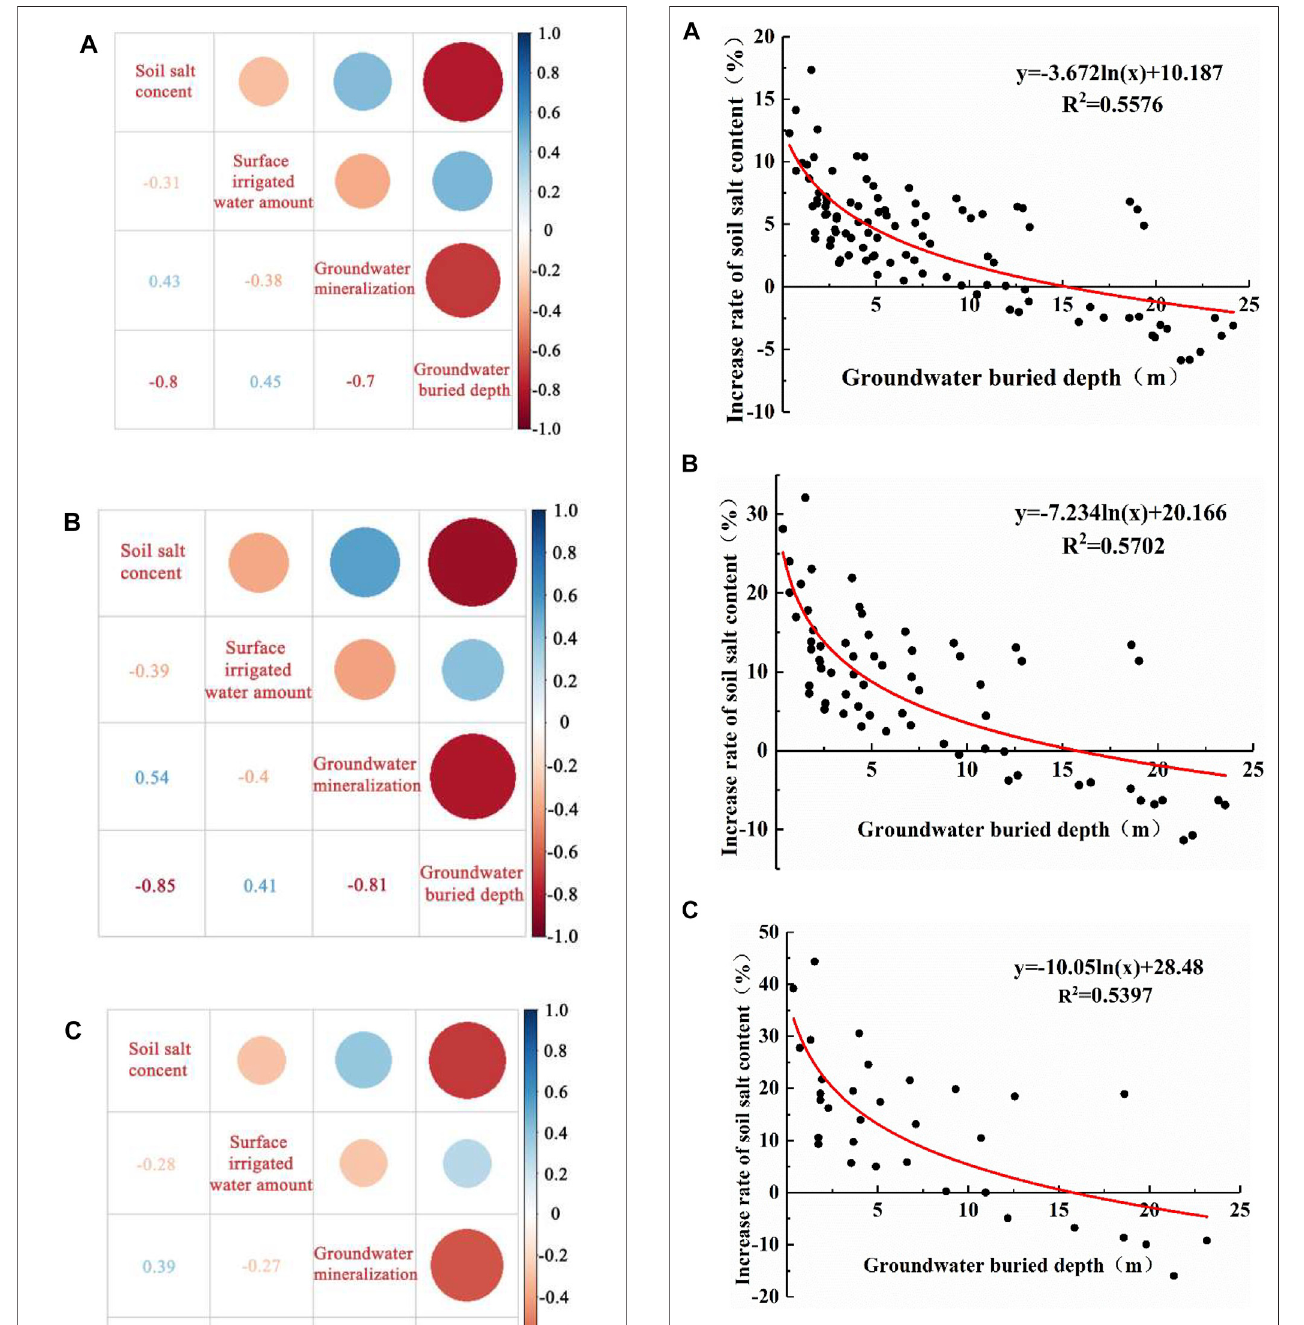
FIGURE 5 | Correlation coef fi cient diagram of various elements of soil salinization under different evaluation methods [ (A) Pearson; (B) Spearman; (C) Kendall].